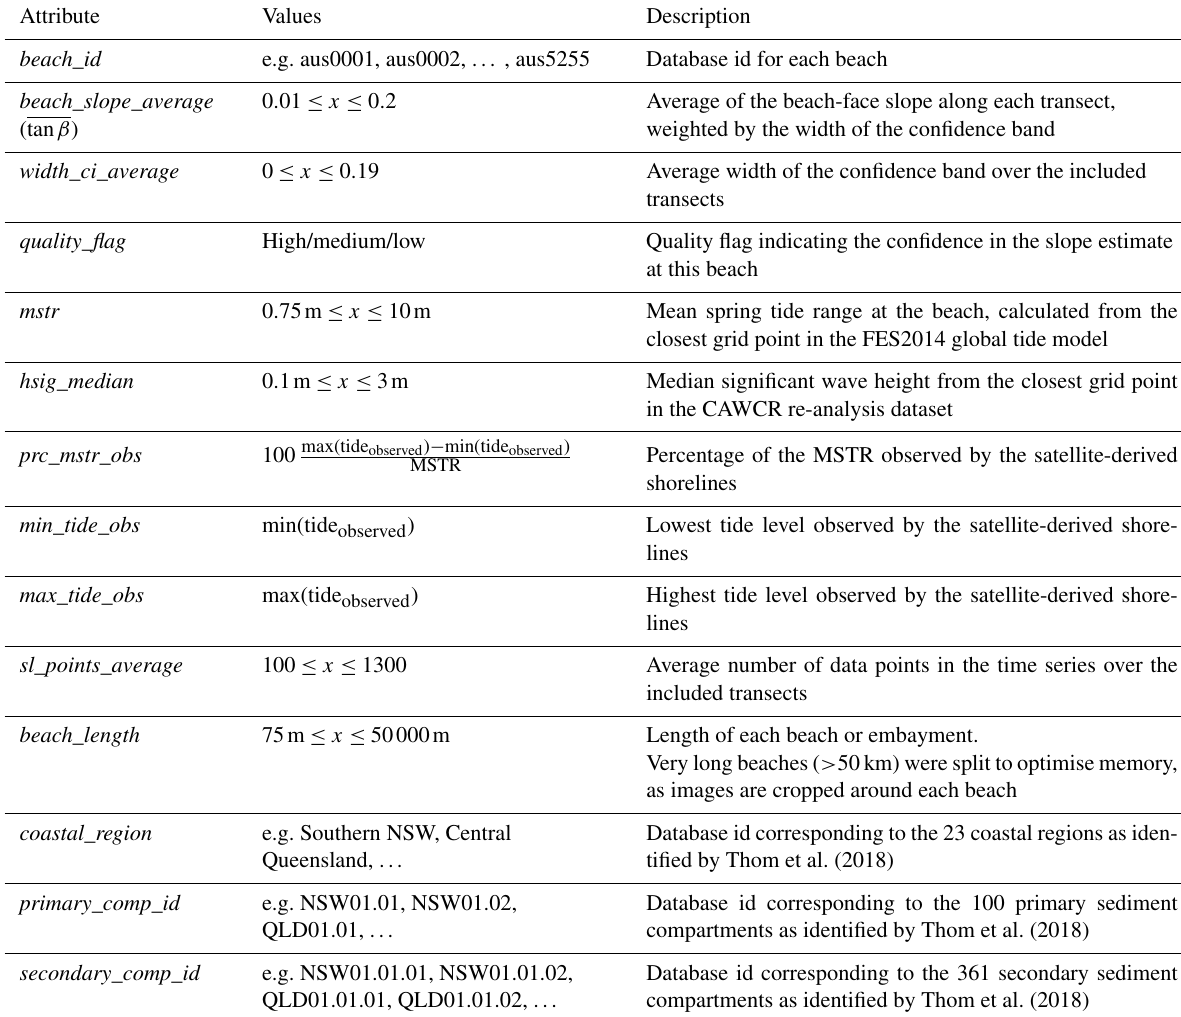
Table 2. Description of data fields for the beach-face slope dataset at the individual beach scale. Attribute Values Description e.g. aus0001, aus0002, ... , aus5255 Database id for each beach Average of the beach-face slope along each transect, weighted by the width of the confidence